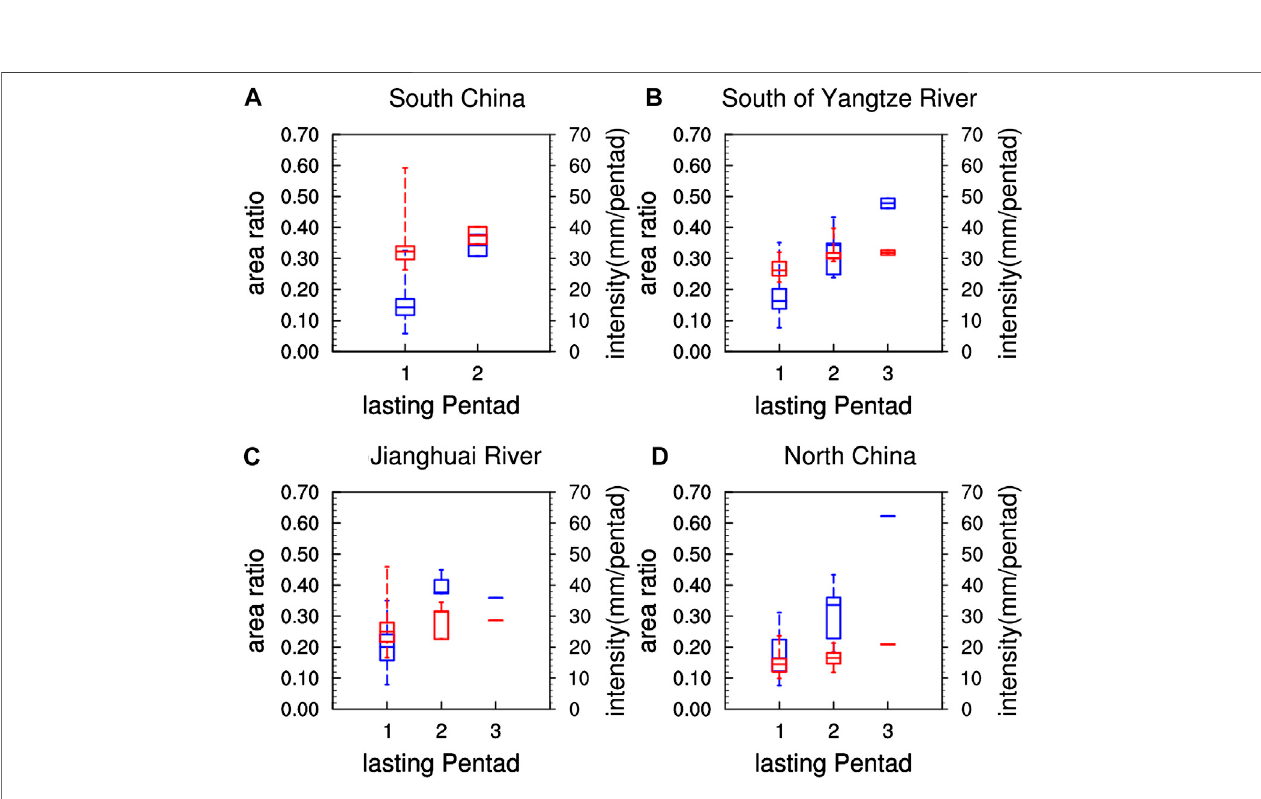
Frontiers in Earth Science |